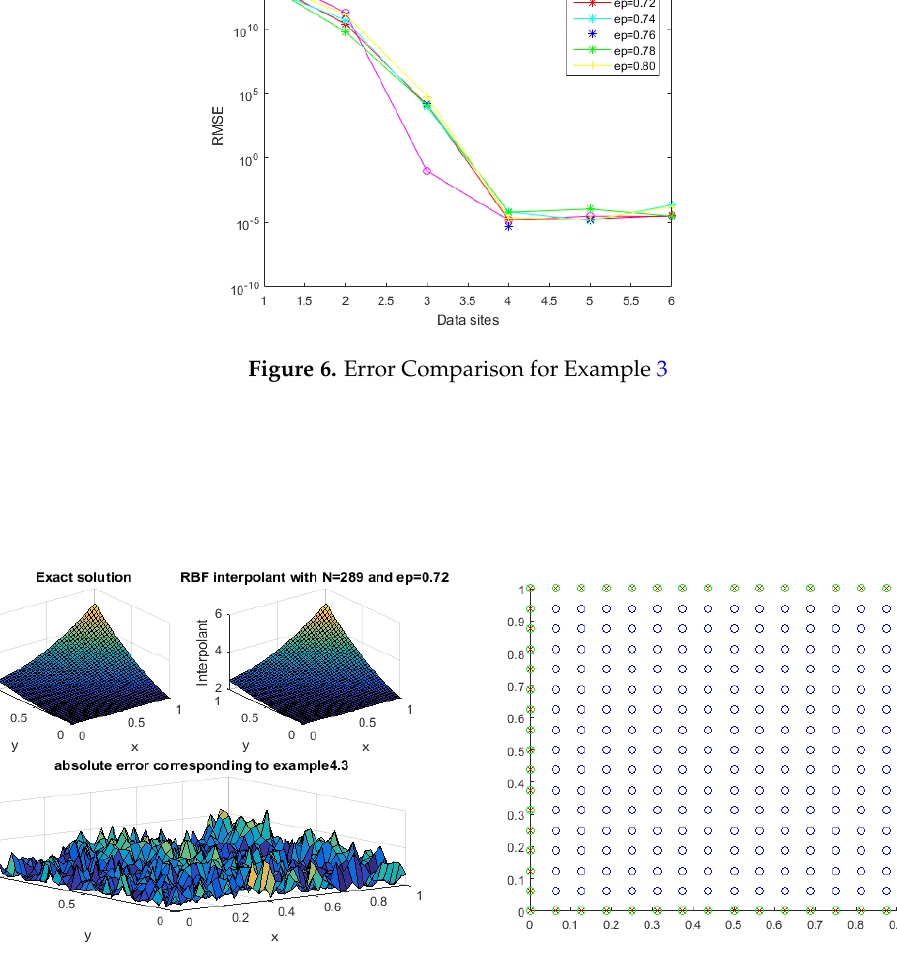
Figure 7. Interpolant for Example 3 and its corresponding data sites